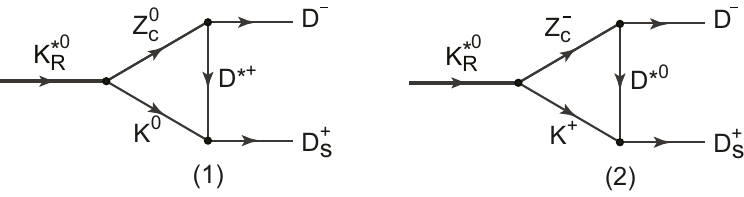
Figure 9 . Contributions related to the diagram (d) of (cid:12)gure 2 for the decay mechanism K (cid:3) 0 ! D (cid:3)(cid:0) D (cid:3) + s R